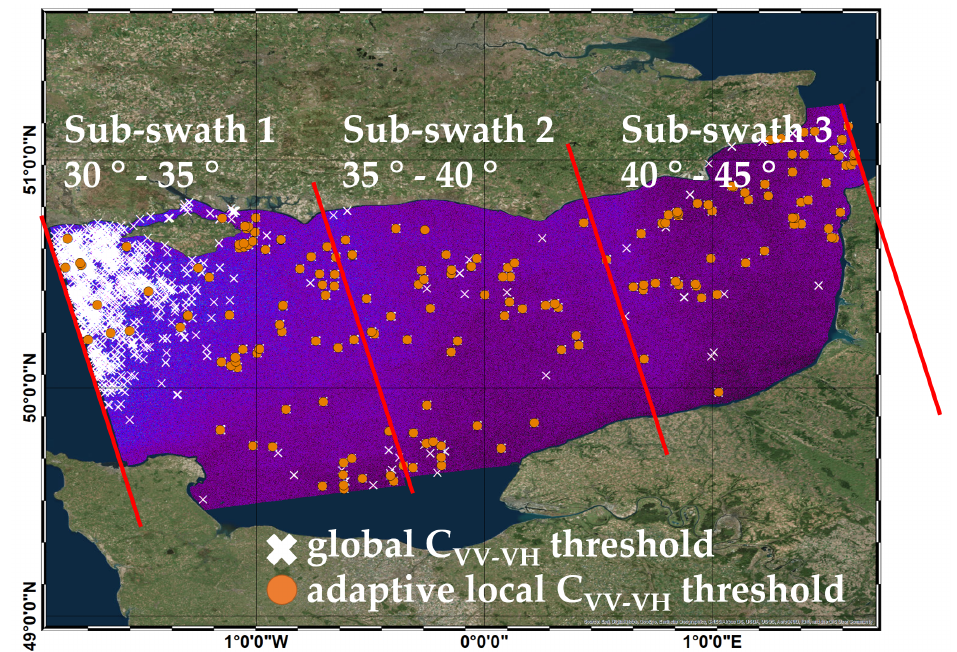
Figure 1. Example of vessel detection results obtained from the dual-polarization-based algorithm by applying both a global and local adaptive threshold to the C un − norm IW